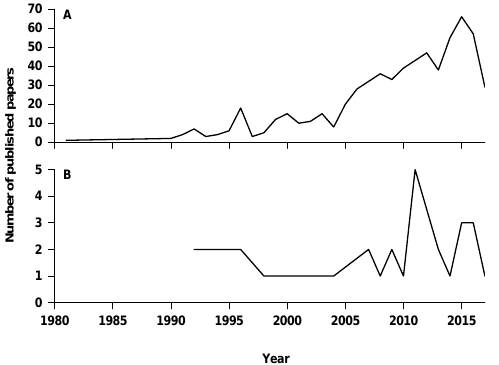
Figure 1. Number of paper hits from the literature search over publication years. ( A ) Total (raw) numbers of all paper types; ( B ) numbers of studies containing mechanistic simulation models. Note the different y-axis scales of both